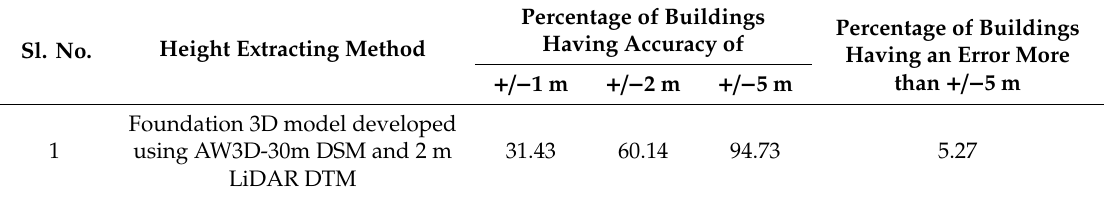
Table 4. Validation results showing percentage of buildings under each interval when ground elevation was extracted using high resolution LiDAR DTM data (Nottingham)